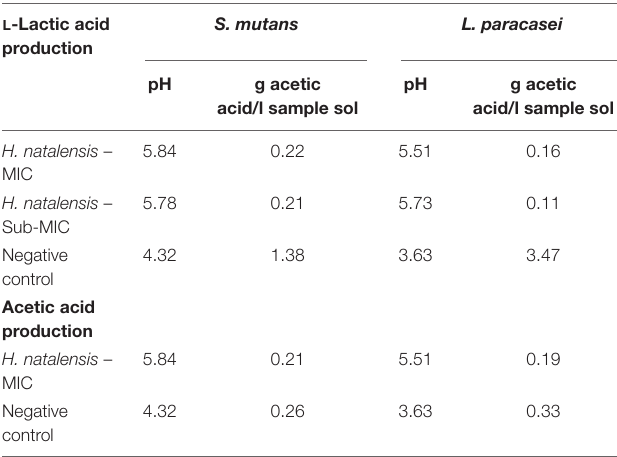
TABLE 3 | Acetic acid and L -lactic acid production by Streptococcus mutans and Lactobacillus paracasei on exposure to ethanolic extract of H. natalensis